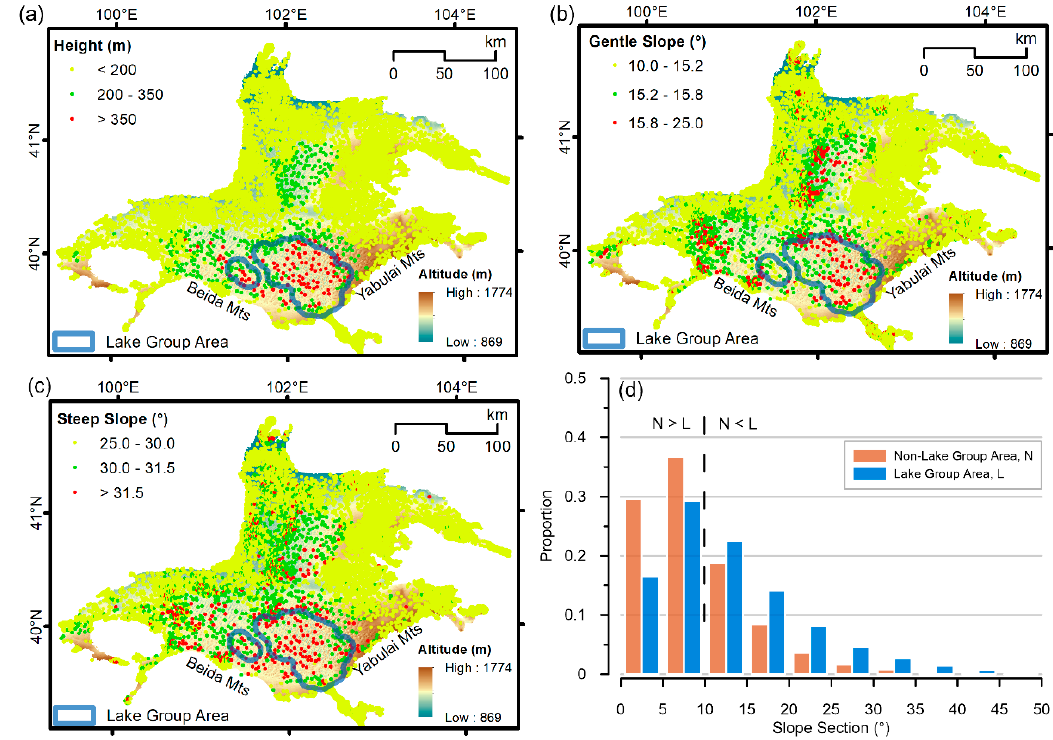
Figure 4. Spatial distributions of the ( a ) relative height of dunes, ( b ) gentle slopes of dunes, and ( c ) steep slopes of dunes in the Badain Jaran Sand Sea. The lake group area features a 10 km buffer zone with lakes at the center [37] in the southeastern part of the Badain Jaran Sand Sea. ( d ) Histogram of slope composition in the lake and non-lake group areas.